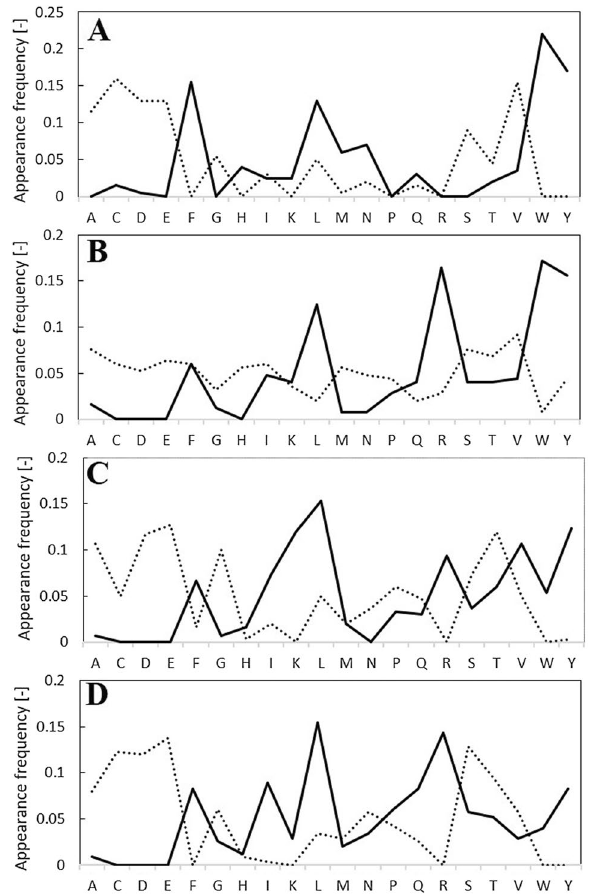
Figure 5. Appearance frequency of amino acid residues for top 50 (solid lines) and bottom 50 (dotted lines) peptides from predictive model [( A ) 4-mer, ( B ) 5-mer, ( C ) 6-mer, ( D )